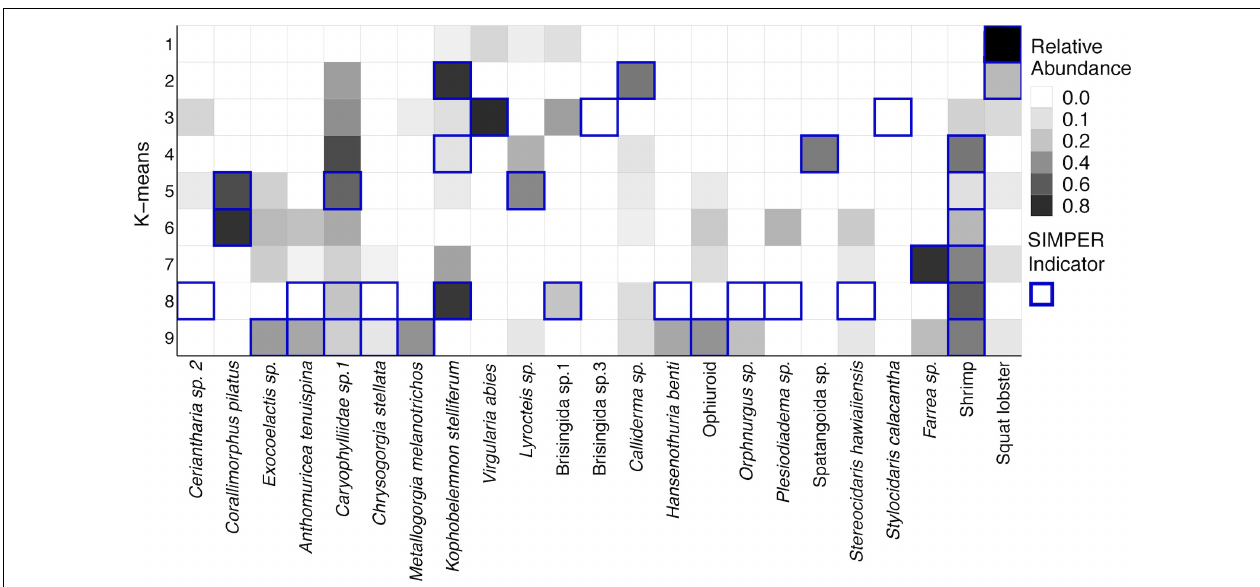
FIGURE 13 | Heatmap of the square root transformed relative abundances of species that define k-means clusters from SIMPER analysis. Along the row for each k-means group, the species indicated by SIMPER analysis as drivers of within-group similarity are outlined in dark